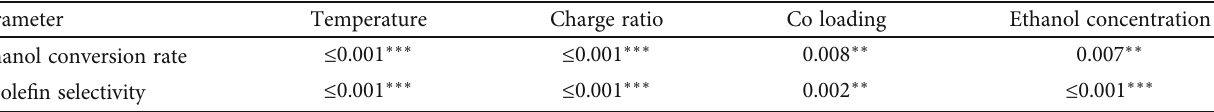
Figure 7: A pedigree of C ole fi n selectivity using average linkage (among groups). 4 Table 2: The results of the signi fi cance test of each